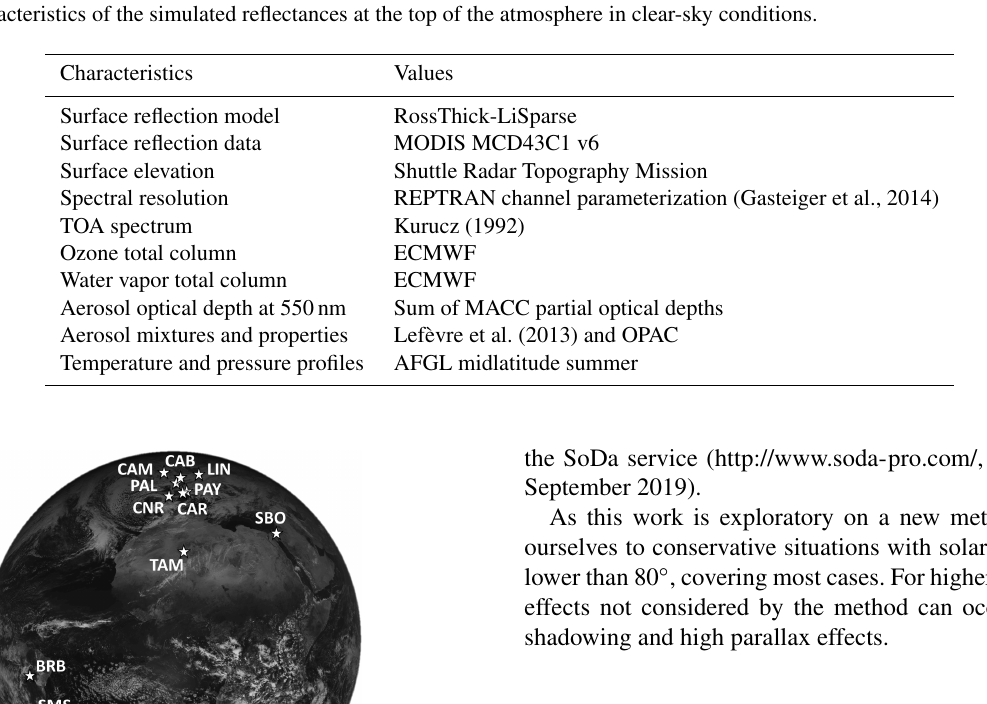
Table 2. Characteristics of the simulated reflectances at the top of the atmosphere in clear-sky conditions.